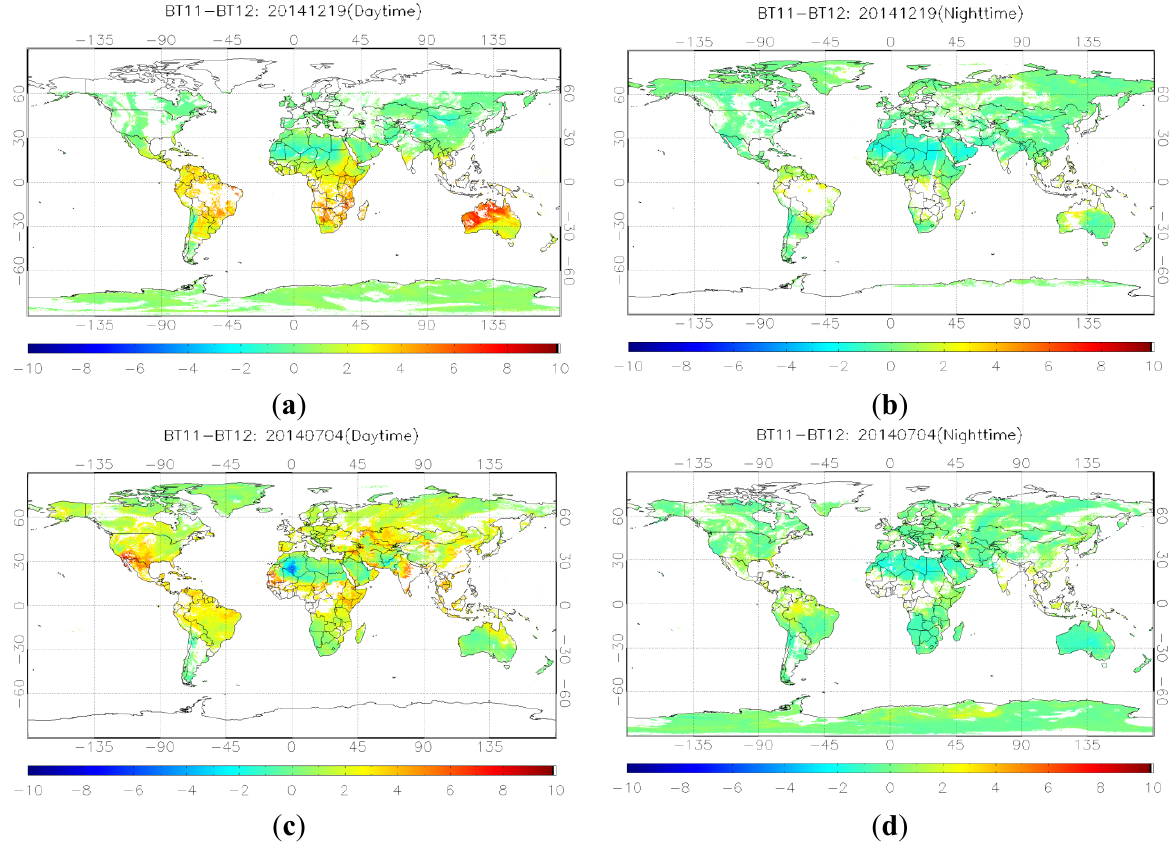
Figure 7. Global BT difference distribution map for 19 December 2014 at daytime ( a ) and nighttime ( b ); 4 July 2014 at daytime ( c ) and nighttime ( d